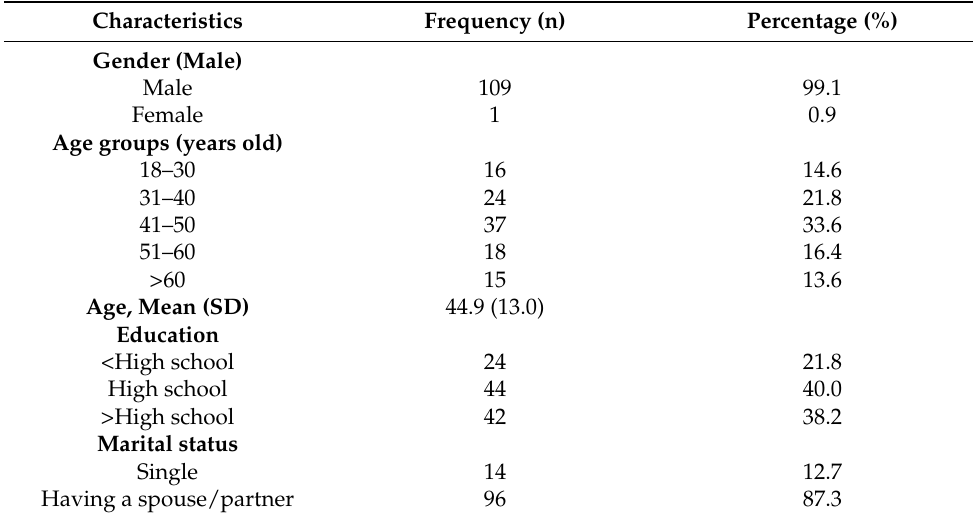
Table 1. Demographic characteristics of respondents (n =